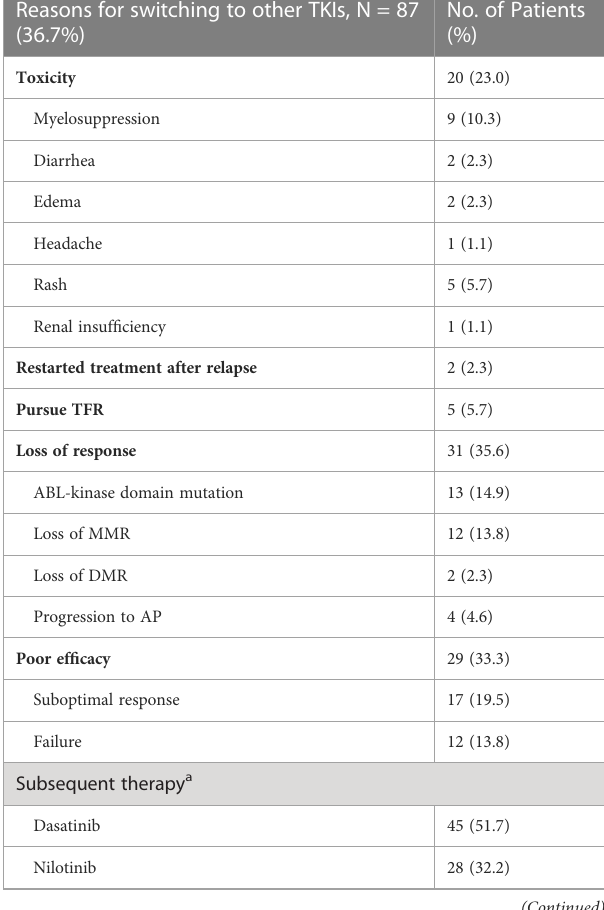
TABLE 3 Characteristics of patients who switch to other